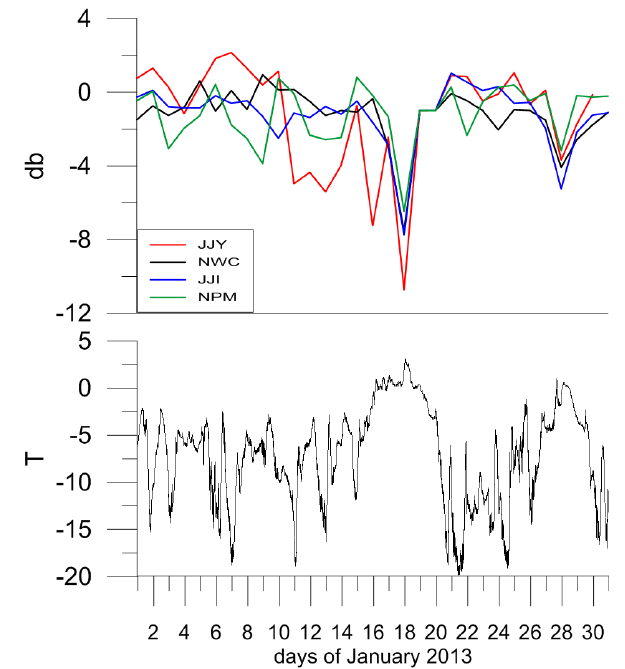
Figure 3. An example of the anomalies observed in the amplitude of the signals recorded at the PTK station during two cyclones in January 2013. The top panel shows the average residual amplitude of VLF/LF signals at nighttime, while the bottom panel refers to the temperature ( ◦